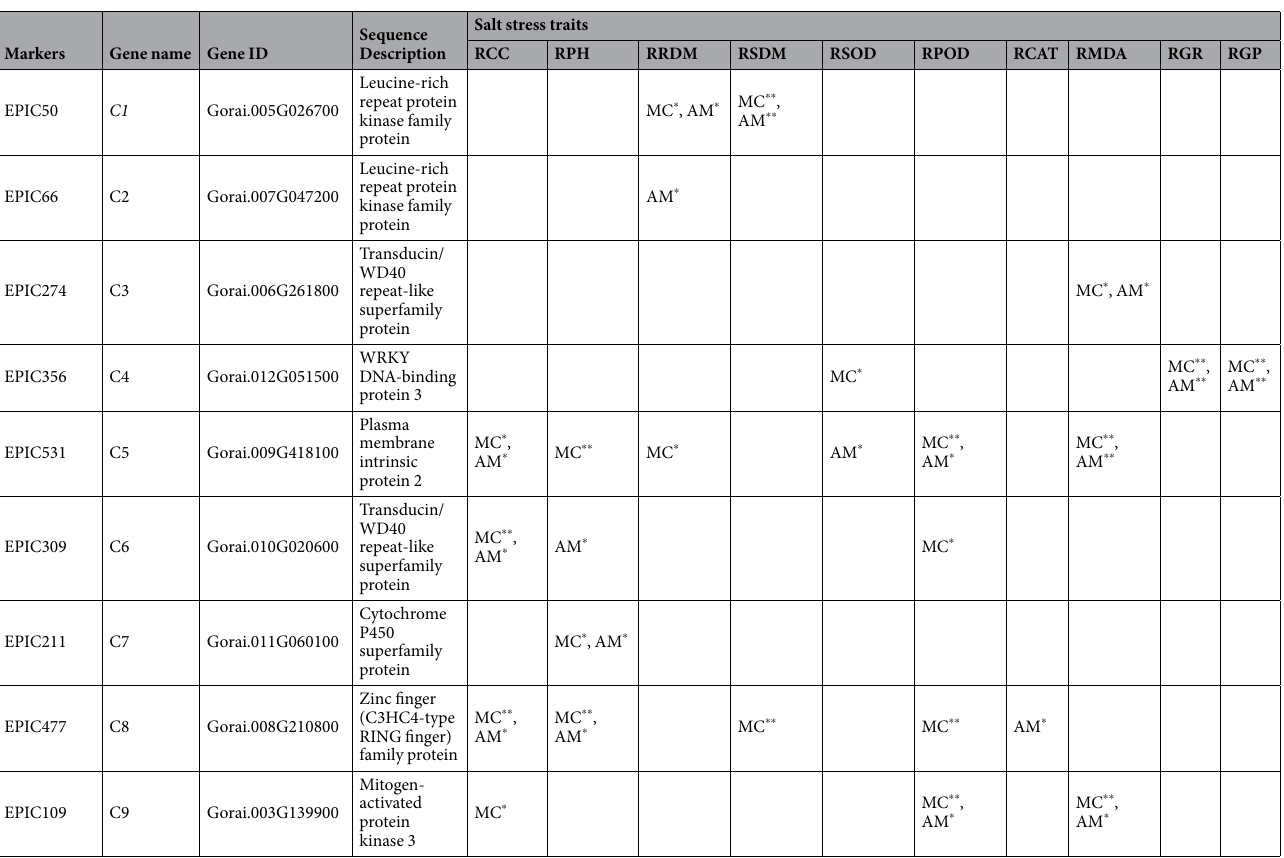
total, 41 alleles were detected, with 2.927 alleles per locus on average (ranging from two to five) and the highest number of alleles detected in EPIC211 (Fig. 2B). The average genetic diversity was 0.400 (ranging from 0.127 to 0.684) and the average polymorphism information content (PIC) was 0.345 (ranging from 0.122 to 0.623). Correlation between ILP markers and the ten salt stress tolerance traits, including relative germination rate (RGR) and germination percentage (RGP) at germinating stage, relative plant height (RPH), shoot dry matter (RSDM), root dry matter (RRDM), chlorophyll content (RCC), malondialdehyde (RMDA) content, and superox- ide dismutase (RSOD), peroxidase (RPOD) and catalase (RCAT) enzyme activity at seedling stages, reported in Du et al . 25 , was assessed using multiple comparison and association analyses. First, multiple comparisons were conducted to analyze the correlations between the ten salt stress traits and each polymorphic ILP marker using the LSR method in SPSS18.0. We found that there were 21 marker-trait cor- relations, involving 8 ILP markers and nine salt stress traits, showed significant differences between polymorphic loci and salt stress trait (P < 0.05). Of these, 13 marker-trait correlations reached statistical significance levels of P < 0.01 (Table S1). Next, we analyzed the population structure of 264 G . hirsutum accessions using STRUCTURE V2.3.3 software based on 14 ILP markers and 145 SSR markers 25 . By comparing LnP (D) and Δ K, we selected K = 7 as the num- ber of subpopulations, and corresponding Q-matrix data were used for the subsequent association mapping. The results showed that 18 marker-trait associations, involving 9 ILP markers and nine salt stress traits, were detected both from the MLM and GLM models (P < 0.05) (Table S2). Integrated with the above two analysis, a total of 25 marker-trait associations involving 9 ILP markers for ten salt stress traits were detected (Table 4). Among these, two ILPs were from the WD40 family, two ILPs were from the leucine-rich repeat family, and the others were from MAPK, P450, WRKY, zinc finger, and aquaporin fam- ilies, respectively. EPIC531, its gene encoding to plasma membrane intrinsic protein, was simultaneously asso- ciated with six salt stress traits: RCC, RPOD, RMDA, RPH, RRDM and RSDM. EPIC477, related to Zinc finger